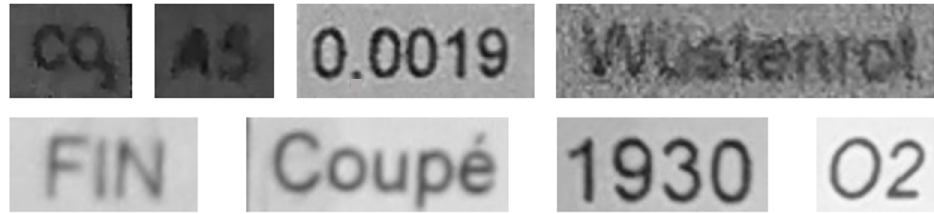
Figure 16. Samples of text recognition inputs obtained by using our Module 1, as shown in Figure 5. The detected text images were cropped from the input image and then used as inputs of the second module to recognize the text information contained therein.